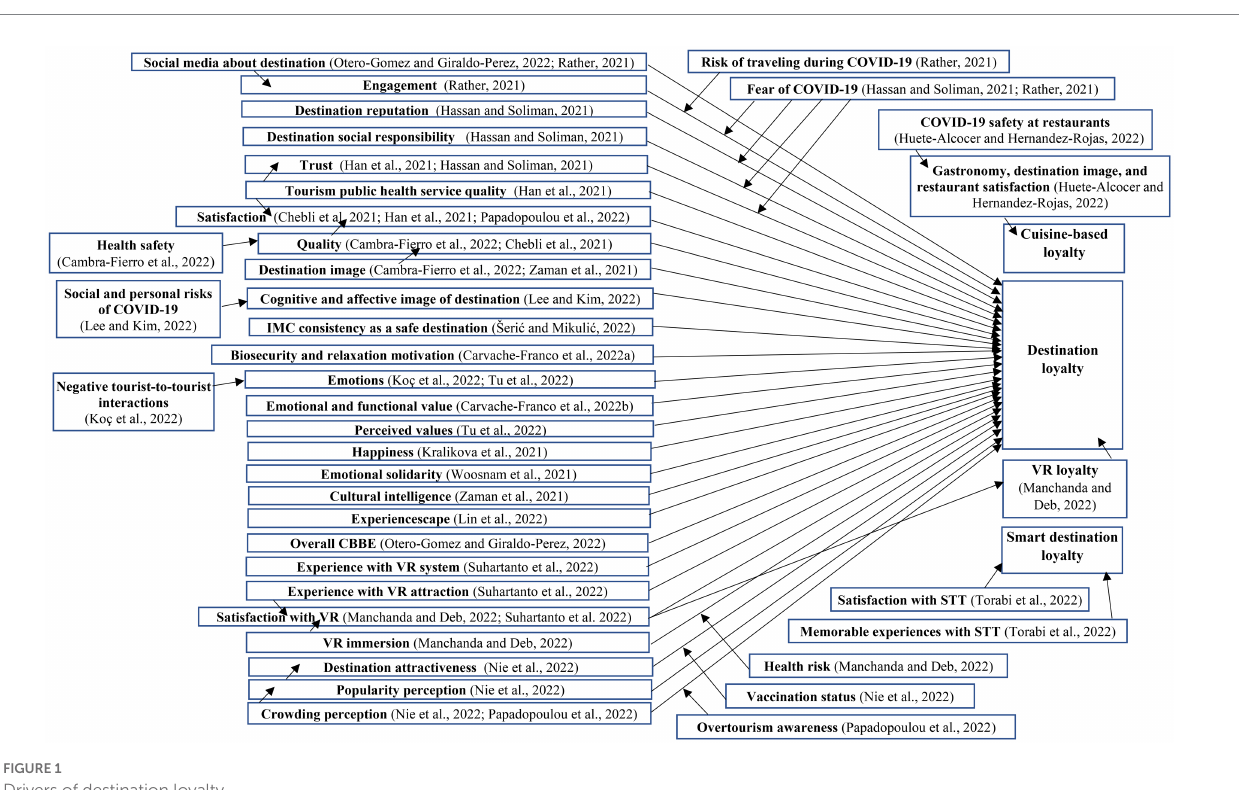
Figure 1. The determinants of destination loyalty found as statistically significant with available effects as Beta coefficients (Vogt and Johnson, 2016) were: satisfaction ( β = 0.790) by Papadopoulou et al. (2022); destination image ( β = 0.530) by Zaman et al. (2021); emotional and functional value ( β = 0.477) by Carvache-Franco et al. (2022b); perceived values ( β = 0.382) and emotions ( β = 0.434) by Tu et al. (2022); happiness